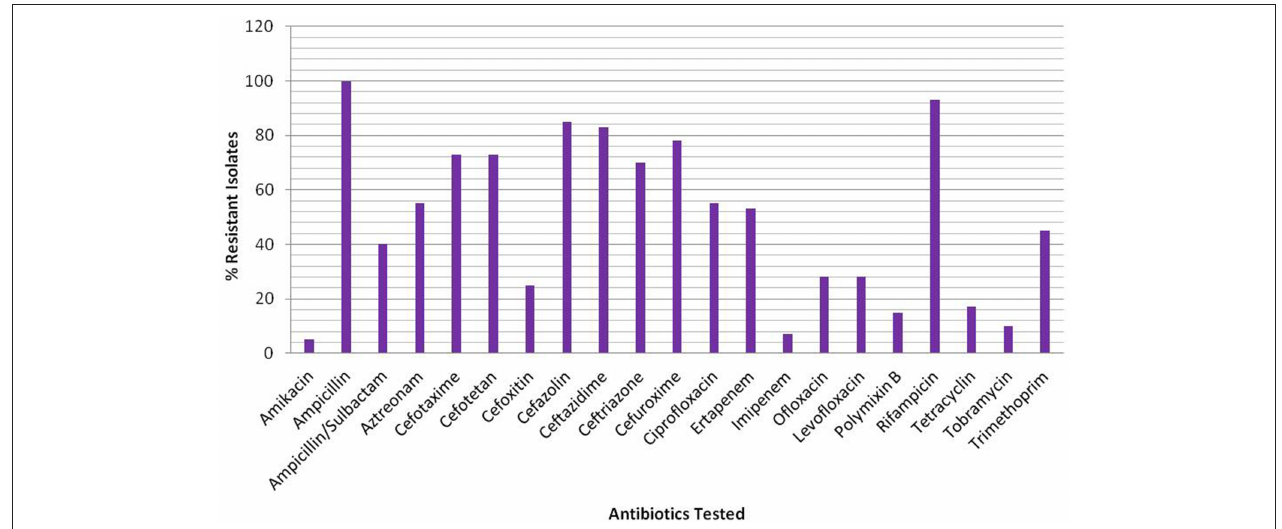
FIGURE 1 | Percentage of resistant isolates against the β -lactam and non β -lactam classes of antibiotics.